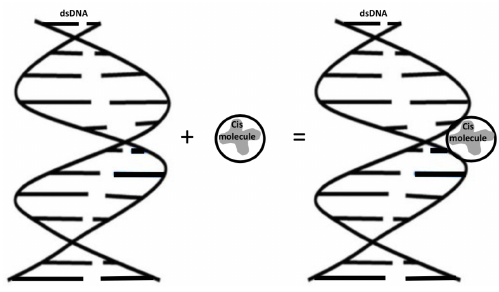
Figure 1. Geometry of a cisplatin molecule binding to